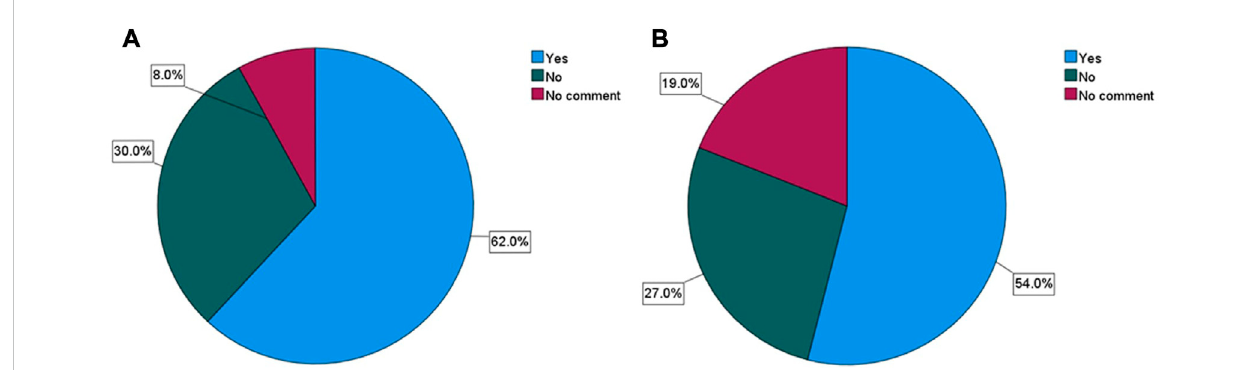
FIGURE 4 Respondents ’ opinionabout (A) whetherplasticbaglevycanencouragethemtoreducetheproductionofplasticwasteand (B) whethertheamount of plastic bag levy should be raised.